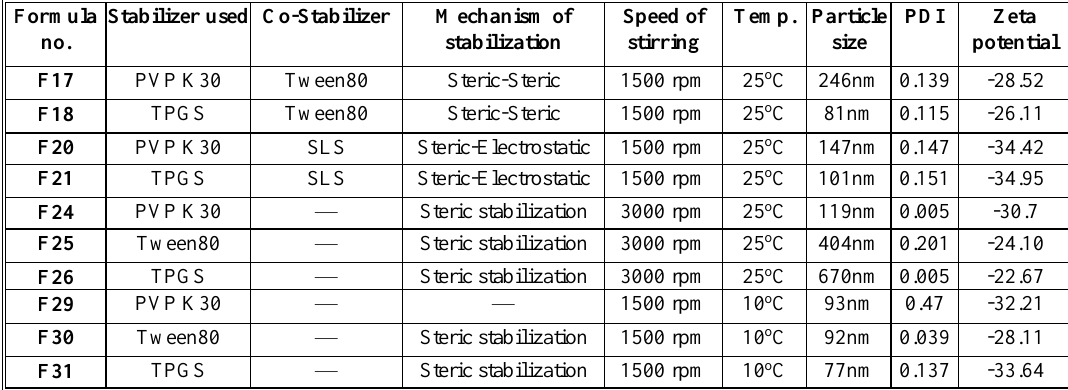
Table 2. Zeta potential values for ten formulations of prepared total 31 formulae.